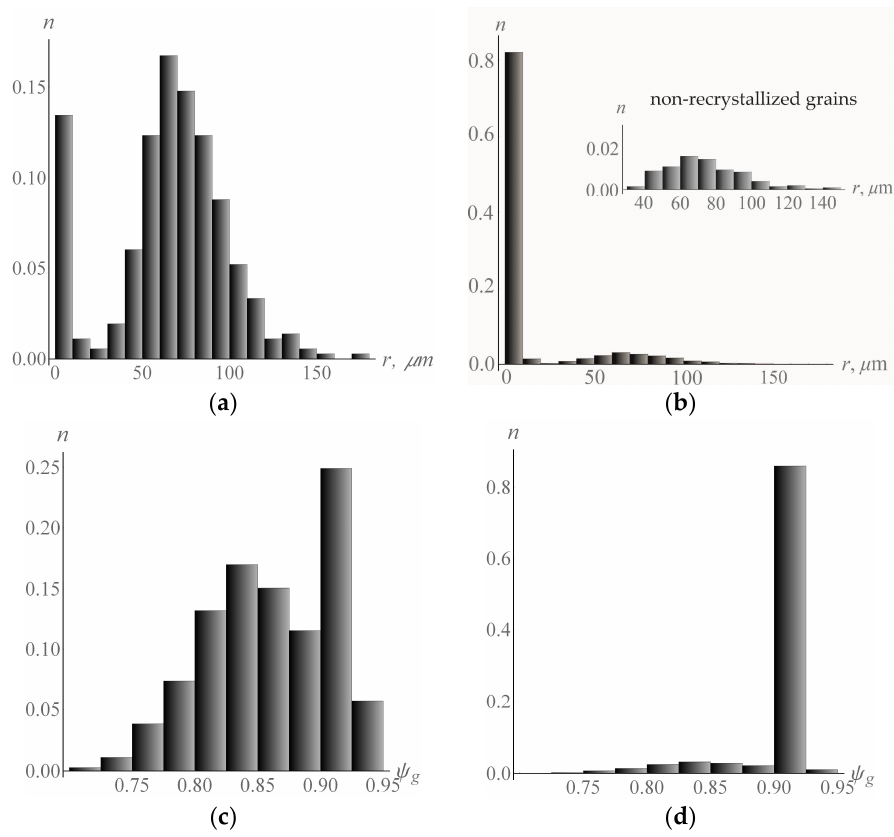
Figure 10. Grain size distribution r g ( a , b ) and grain sphericity ψ g ( c , d ) histograms at different instants of deformation ε m and ε f ,